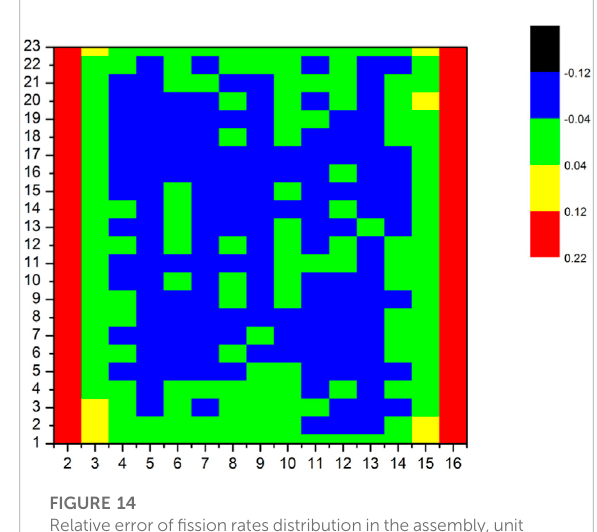
FIGURE 14 Relative error of fi ssion rates distributionin the assembly, unit in %. Fuel blocks are numbered starts from 2.